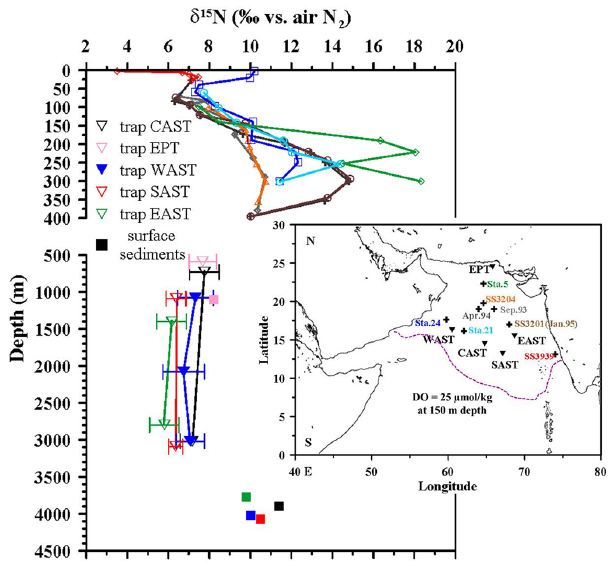
Figure 6. Vertical profiles for nitrogen isotope of nitrate (crosses in inserted map), sinking particles (inverse triangles in map) and trap-corresponding surface sediments. Data for sediment traps and surface sediments are from Gaye-Haake et al. (2005). Depth profile of δ 15 N NO follows that in Fig. 3